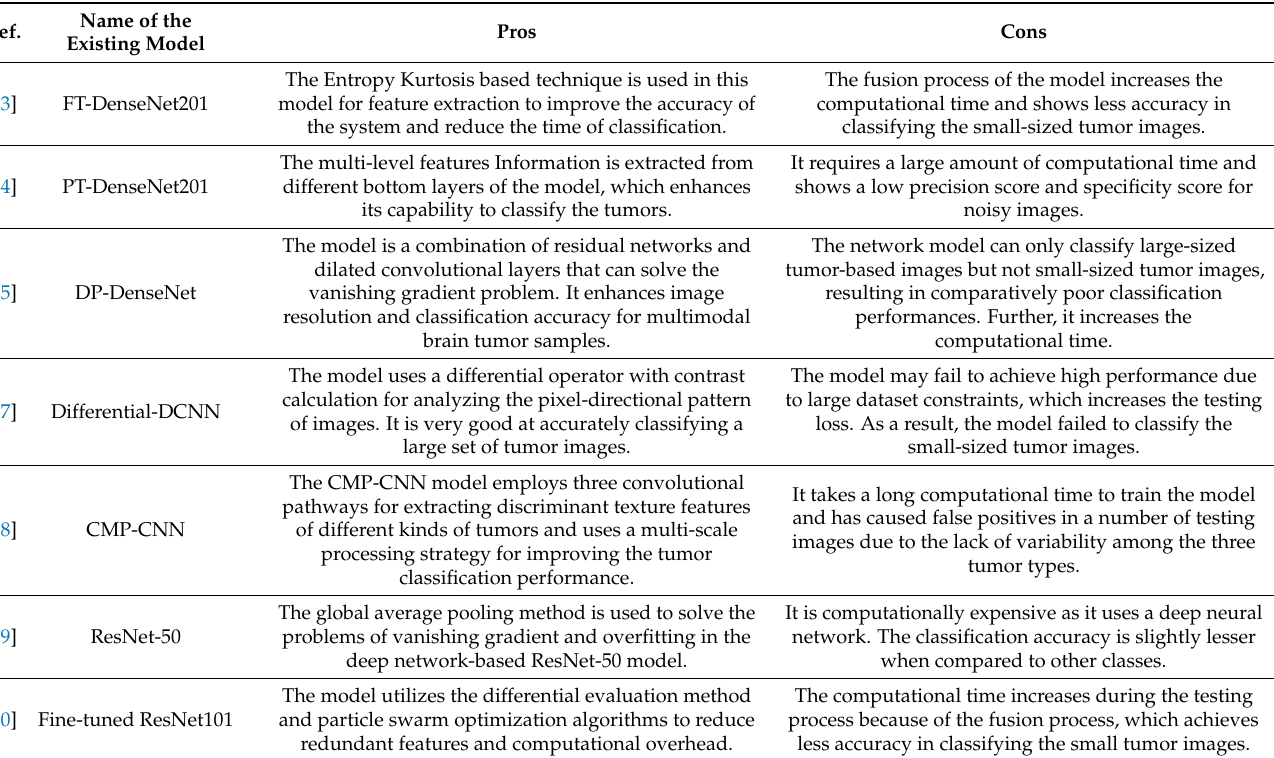
Table 1. Summarizes the pros and cons of the existing models mentioned in the literature